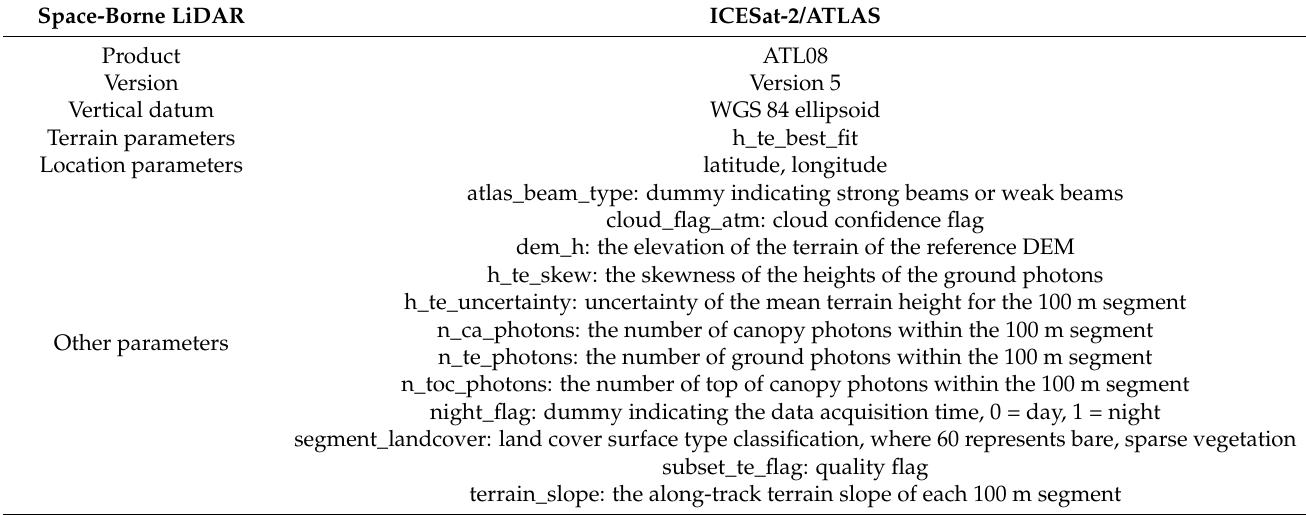
Table 2. Details of the ATL08 product and the extracted